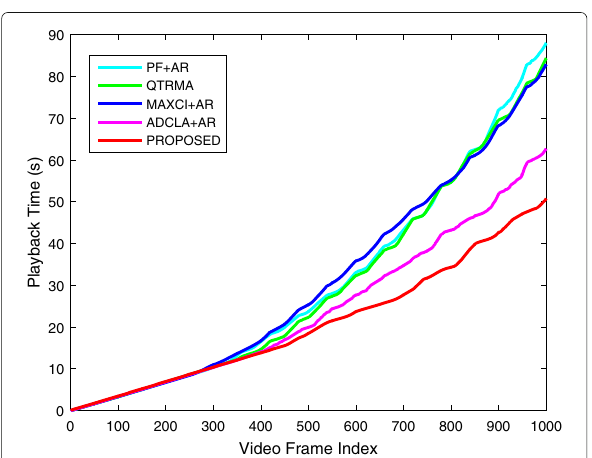
Fig. 7 Average packet loss rate of all the clients for each frame for different